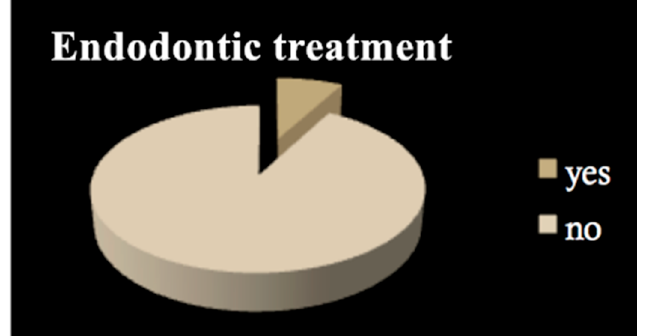
Figure 2. Endodontic treatment.